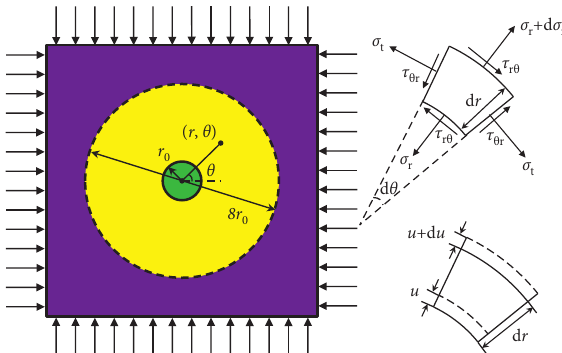
Figure 3: Simplified model of stress distribution around working